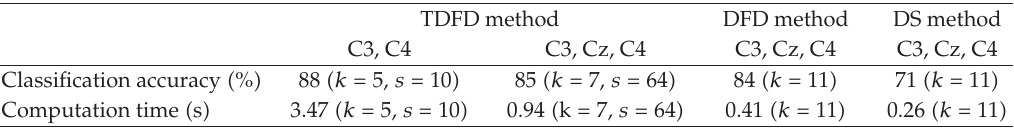
Table 3: Computation times and classification accuracies obtained by modifying the highest performing methodology (cid:4) Katz’s Method with FKNN (cid:5) (cid:4) and the parameters (cid:4) k and s (cid:5) used to obtain these values (cid:5)